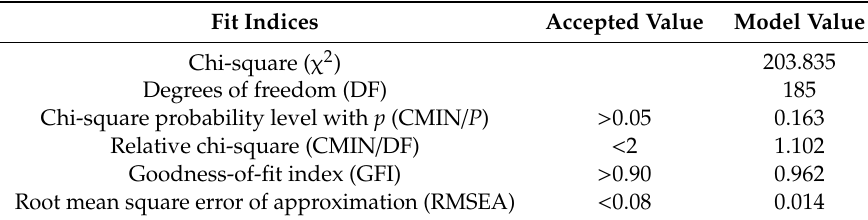
Table 2. Goodness-of-fit indices for structural